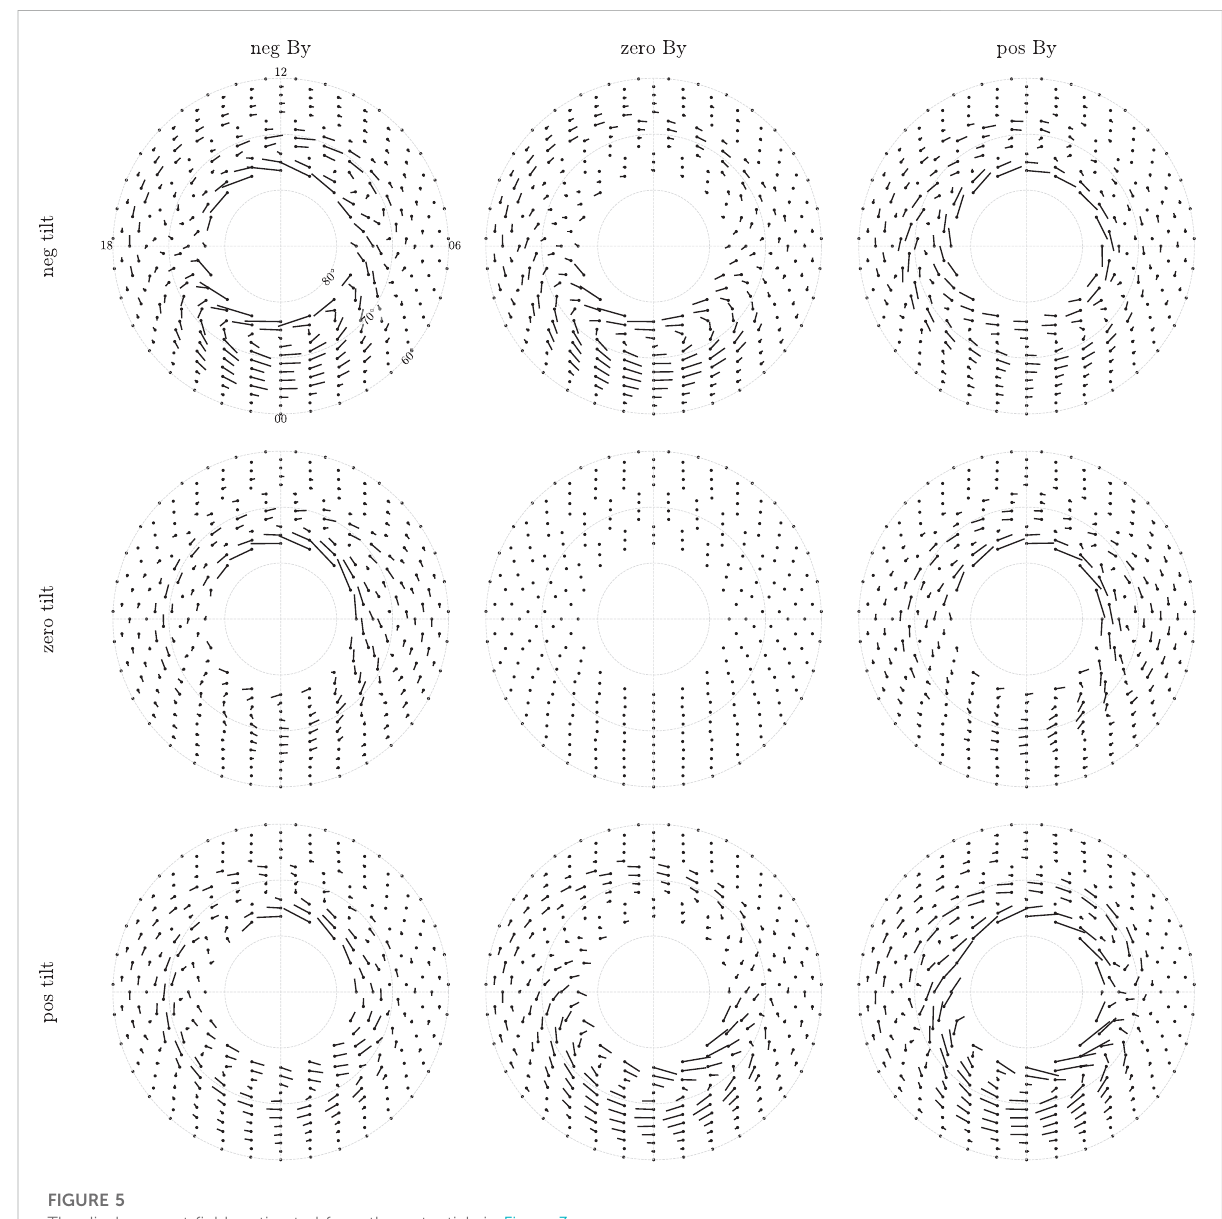
FIGURE 5 The displacement fi elds estimated from the potentials in Figure